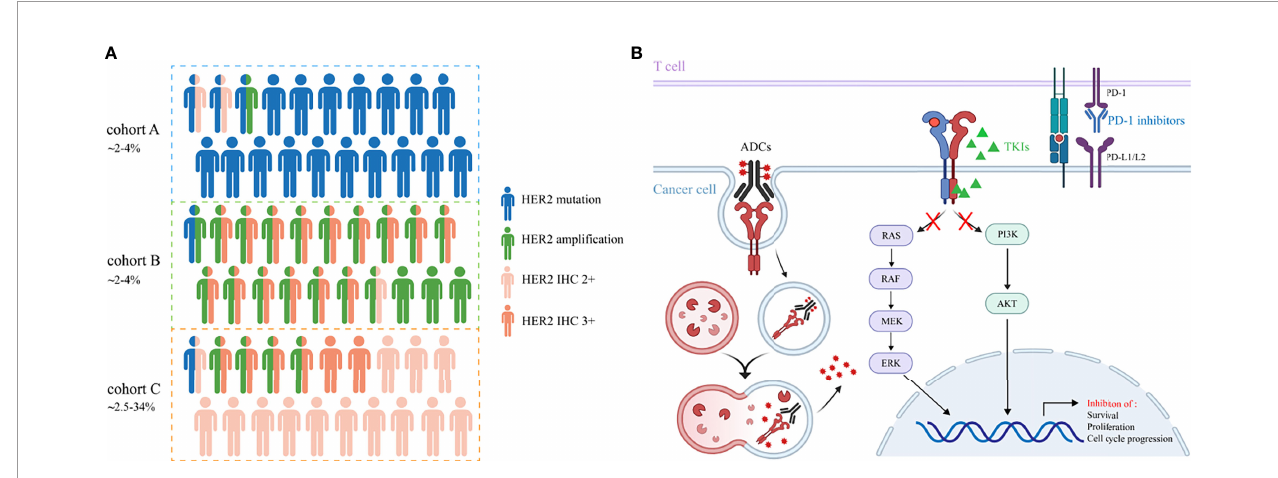
FIGURE 1 | (A) The incidence rates and associations of HER2 alterations in NSCLC. Cohort A, B and C represent HER2 mutation, ampli fi cation and overexpression, respectively. Cohort C includes patients with IHC 2+ and 3+. (B) The underlying mechanisms of TKIs, ADCs and immune checkpoint inhibitors to cope with HER2-altered